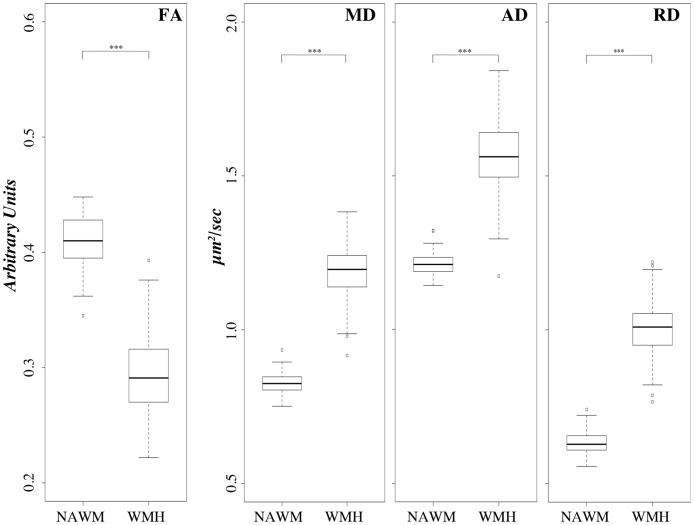
Comparison of DTI indices between NAWM and WMH at baseline.Boxplots illustrate the values distribution (y-axis) of the fractional anisotropy (FA), mean diffusivity (MD), axial diffusivity (AD) and radial diffusivity (RD) indices within the normal-appearing white matter (NAWM) and within the white matter hyperintensity (WMH) areas. FA expressed in arbitrary units; MD, AD and RD expressed as μm2/sec. Baseline sample, N = 86. *** Statistical significance of p≤10−7 in Wilcoxon signed rank one-sample test.